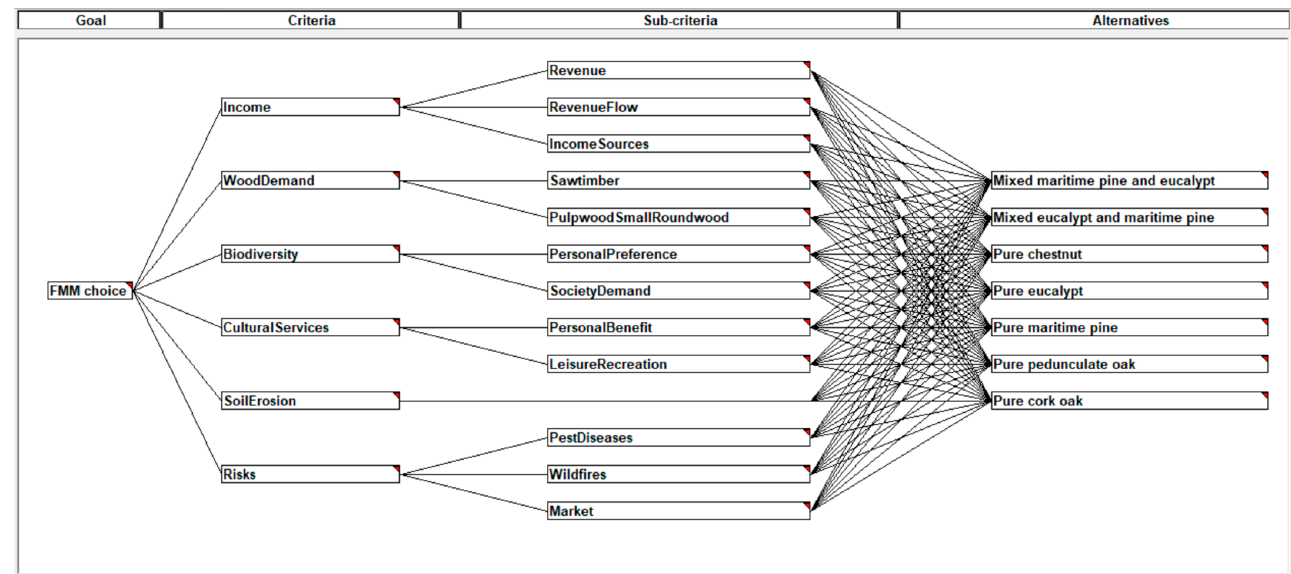
Figure 3. Cognitive map developed with actors during the workshop.